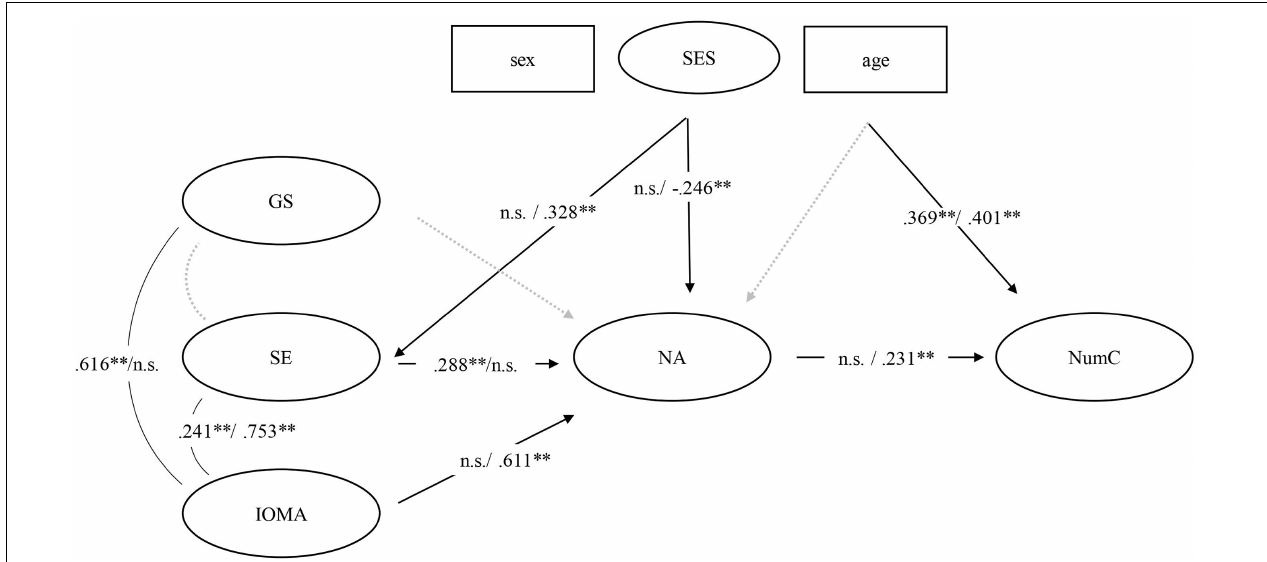
FIGURE 2 | Path analysis of the associations between mothers’ and fathers’ beliefs toward mathematics, their numeracy activities at home, and numeracy competencies of the children. NumC, children‘s numeracy competencies; NA, numeracy activities at home; GS, gender stereotypes; SE, self-efficacy; IOMA, importance of mathematical activities at home. Sex, children’s sex; Age, children’s age in month. Black lines indicate significant associations, and dotted gray lines indicate non-significant associations. ∗∗ p < 0.01, n.s., non-significant. Path coefficients for mothers/fathers.